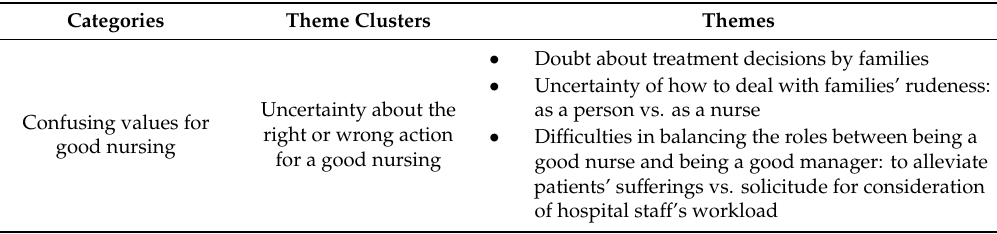
Table 2. Summary of themes, theme clusters, and